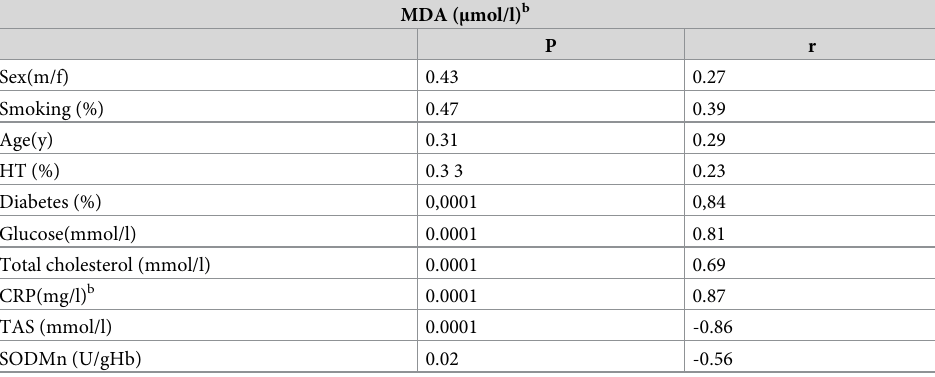
Table 3. Correlation between MDA levels and some parameters in CRF patients by univariate analysis.